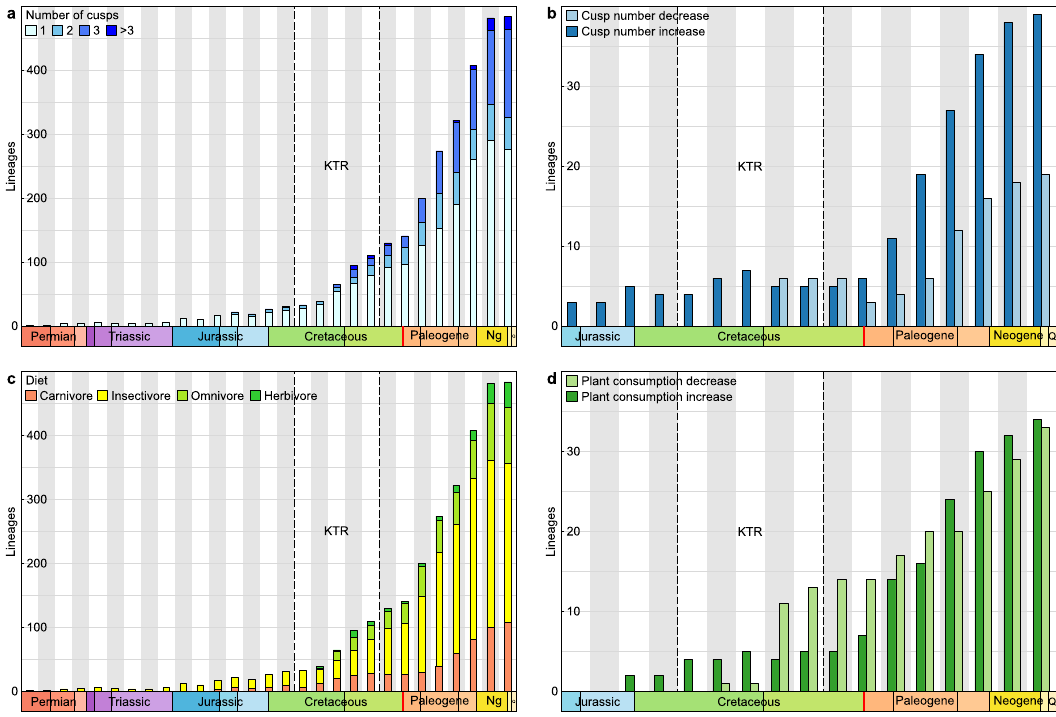
Fig. 3 Dynamics of squamate tooth complexity and plant consumption evolution. Squamate lineages sorted by cusp number ( a , single-cusped: n = 651, two-cusped: n = 145, three-cusped: n = 238, more than three cusps: n = 33) and diet ( c , carnivore: n = 246, insectivore: n = 556, omnivore: n = 203, herbivore: n = 62) per 10 million year-time bins based on maximum likelihood ancestral state reconstructions. Lineages showing increasing ( n = 61) or decreasing ( n = 31) tooth complexity ( b ) and increasing ( n = 51) or decreasing ( n = 64) plant consumption ( d ) per 10 million year-time bins. KTR: Cretaceous Terrestrial Revolution (~125 – 80 Ma). Q: Quaternary. Decreases in both cusp number and plant consumption proportion fi rst outnumber increases during the Cretaceous Terrestrial Revolution (KTR), while the Cretaceous – Paleogene boundary (in red) shows the change towards the Cenozoic pattern of approximately twice as many cusp increases as decreases, and similar numbers of plant consumption increase and decrease from the Paleogene on. Source data are provided as a Source Data fi